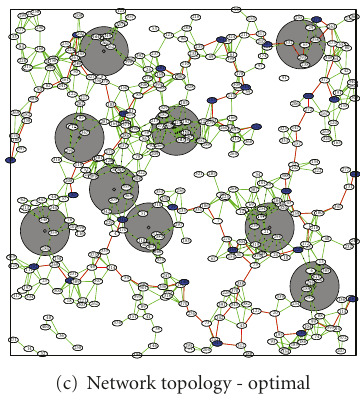
(c) Network topology - optimal Figure 15: Network topology; green links—actual, “physical” links; red—links used for Steiner tree; blue nodes—terminal nodes (members of set L ); dark gray area—area under jammers’